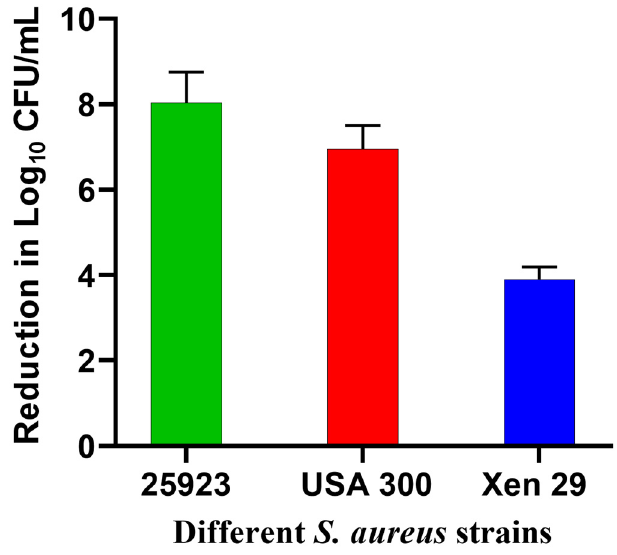
Figure 5. Reduction in the viability of different strains of S. aureus biofilms after incubation with GaPP-LCNP in TSB for 24 h in the dark, presented as log 10 reduction in CFU count vs. different biofilm strains; data presented as mean ± SD.